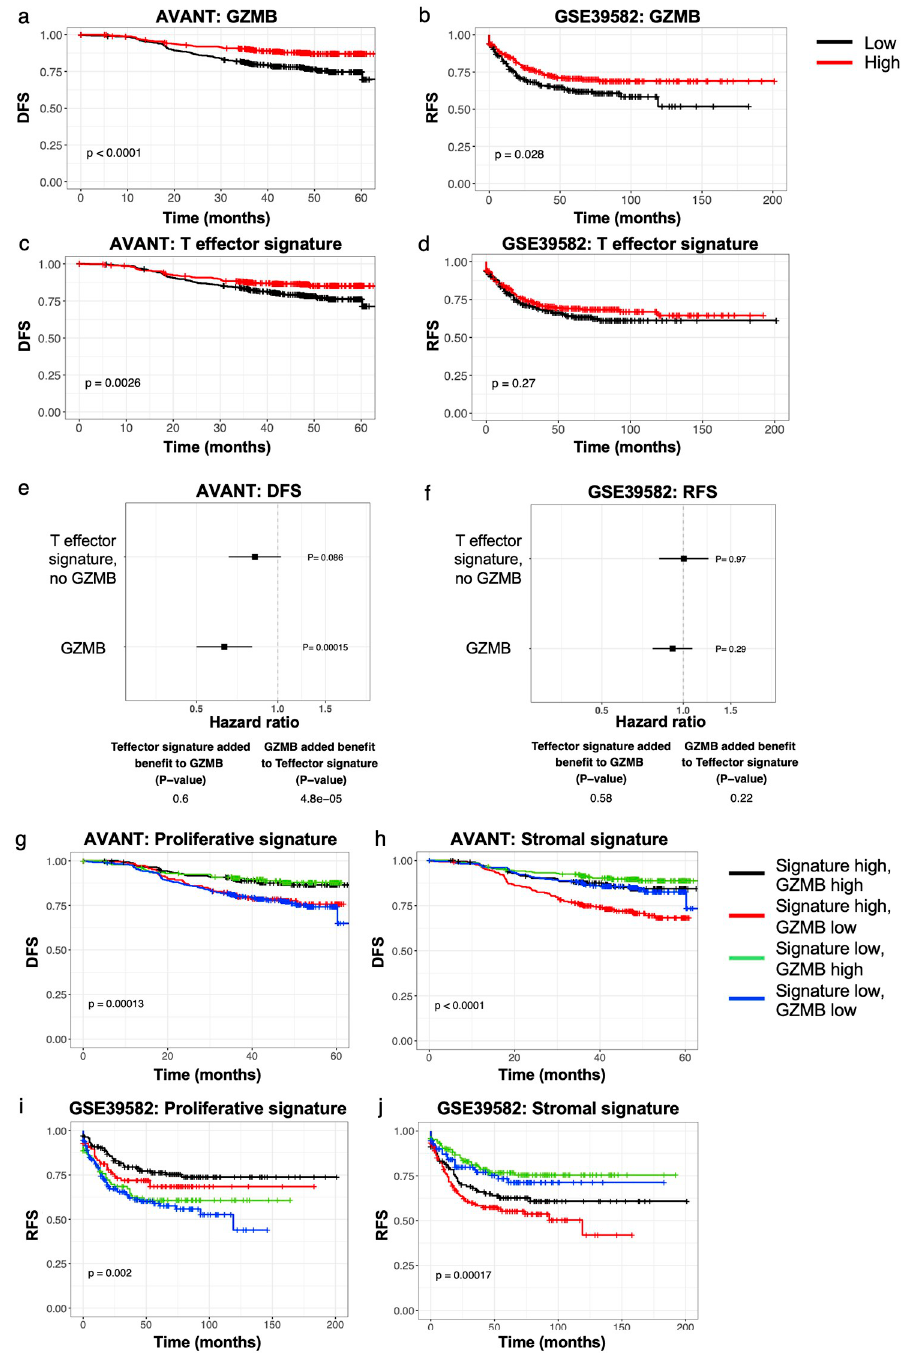
Fig 2. GZMB is a prognostic, T cell independent biomarker in CRC. (a-b) Kaplan-Meier curves for GZMB expression stratified by median in (a) the AVANT BEP dataset for DFS and (b) GSE39582 for RFS. (c-d) Kaplan-Meier curves for the T-effector signature stratified by median expression in (c) the AVANT BEP dataset and (d) GSE39582. (e-f) Forest plots show hazard ratios and associated p-values for the T-effector signature without GZMB and for GZMB expression in (e) the AVANT BEP dataset and (f) GSE39582. The tables below indicate the significance of added prognostic value (if any) provided by the T-effector signature when added to GZMB (first column) and vice versa (second column). Note that continuous GZMB expression in GSE39582 is not prognostic, contrary to high vs. low GZMB expression in panel (b). (g-j) Kaplan-Meier curves showing the relationship between GZMB and (g) the proliferative genes or (h) the stromal genes of the AVANT signature in the AVANT BEP dataset; and between GZMB and (i) the proliferative genes or (j) the stromal genes of the AVANT signature in GSE39582. P-values correspond to a log-rank